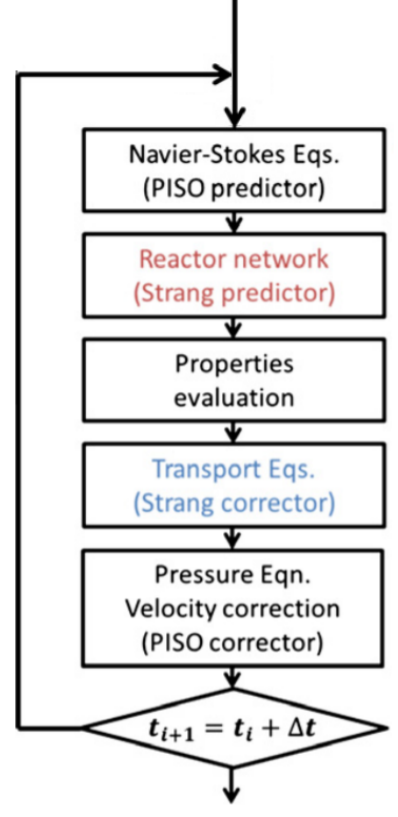
Figure 1. Numerical algorithm, adapted from Cuoci et al.